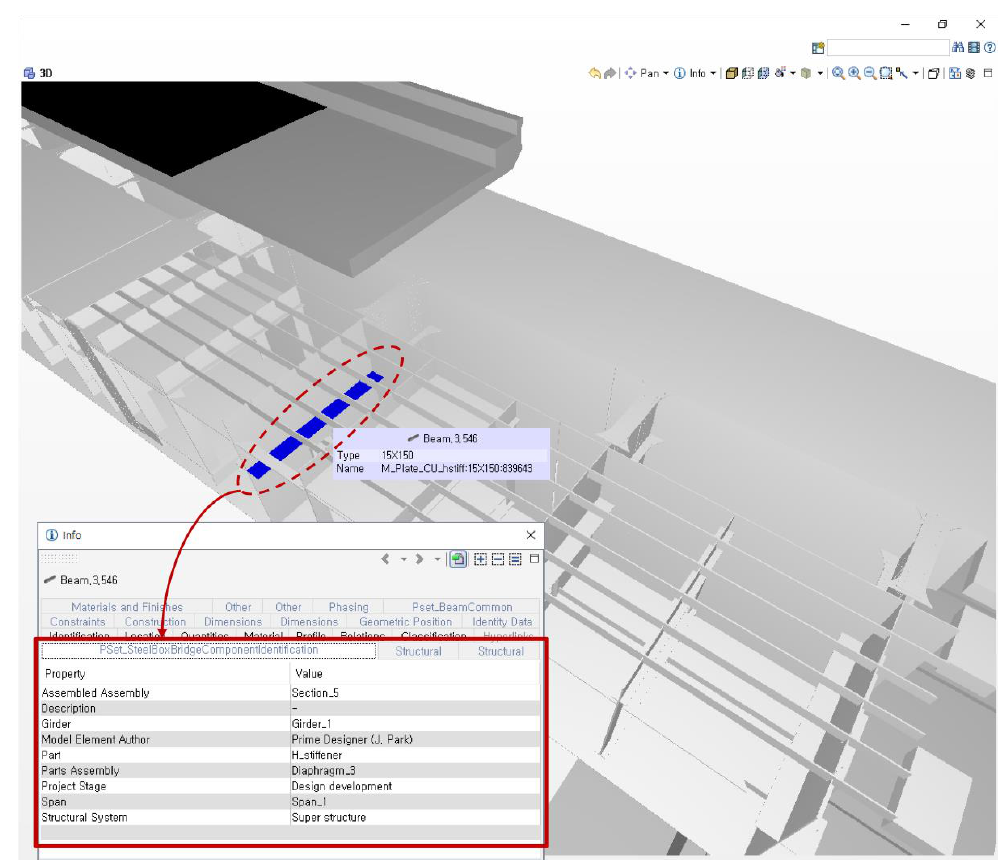
Appl. Sci. 2018 , 8 , x FOR PEER REVIEW Figure 12. The result of the detailed design-level bridge information model. Figure 12 . The result of the detailed design-level bridge information model.